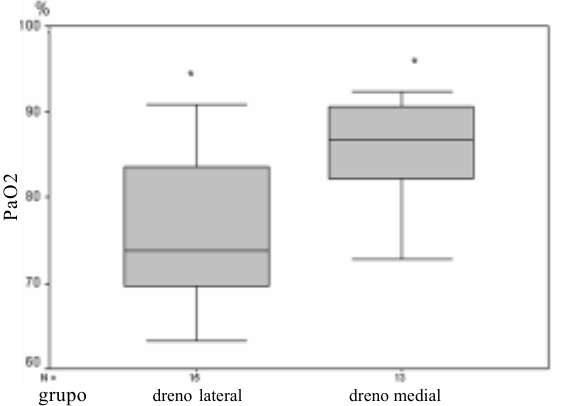
Fig. 4 - Distribuição representativa das alterações da pressão parcial de oxigênio arterial (PaO ) em percentual no 1º dia de PO em 2 relação aos valores pré-operatórios, comparação entre os grupos com inserção do dreno pleural nas regiões lateral e medial, considerando como 100% o valor basal do